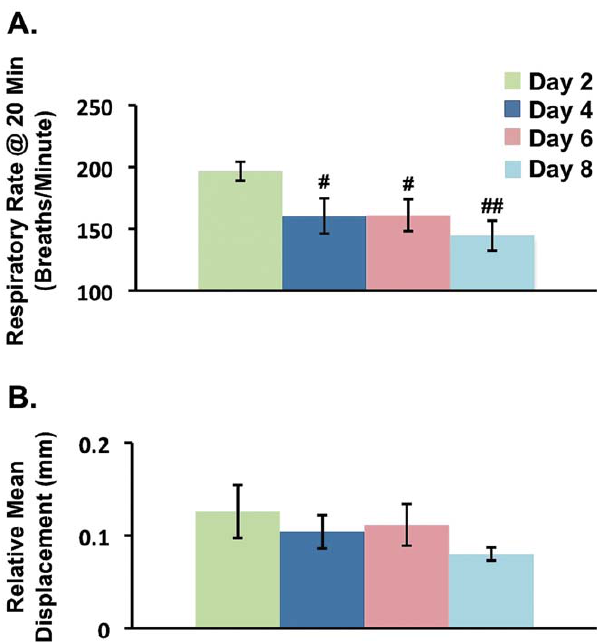
Figure 1. Respiratory Rates and Head Displacement During Awake Resting-State fMRI for Days 2-8. A. Respiratory rates significantly decreased between Day 2 and every other scanning session (Days 4-8) where the lowest respiratory rate was measured at Day 8. Respiratory rates between Day 2 and each of the other scanning days (Days 4, 6 and 8) were statistically compared using a 2-tailed unpaired, t-tests. ( Day 4 : t 10 =2.42, p=0.036; Day 6 : t 12 =2.52, p=0.027; Day 8 : t 12 =3.64, p=0.027) The ANOVA test revealed significant between day differences for respiratory rate (F 3,22 =3.99, p=0.021), but not for head displacement (F 3,22 =0.88, p=0.47). B. Head displacement was less than the size of the imaging voxel for all scanning sessions, but did not significantly differ between Days 2-8. The displacement is relative to a reference volume (Volume 60 of 120). Respiratory rates and head displacement between Day 2 and each of the other scanning days (Days 4, 6 and 8) were statistically compared using a 2-tailed unpaired, t-tests ( Day 4 : t 10 =0.58, p=0.57; Day 6 : t 12 =0.39, p=0.70; Day 8 : t 12 =1.55, p=0.15). Error bars represent s.e.m. Day 2 (N=7); Day 4 (N=5); Day 6 (N=7); Day 8 (N=7). # p , 0.05 and ## p , 0.005.